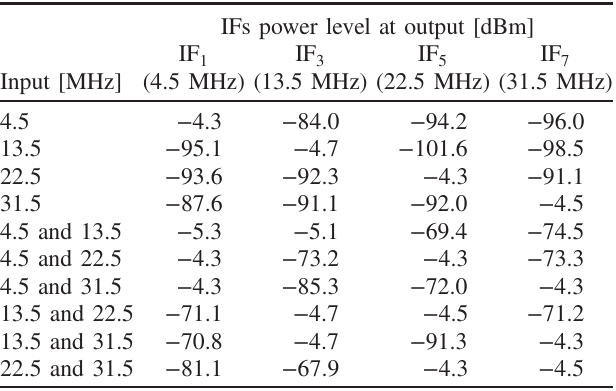
TABLE II. Power at combiner output (test point 1) with two- tone input measured by spectrum analyzer.